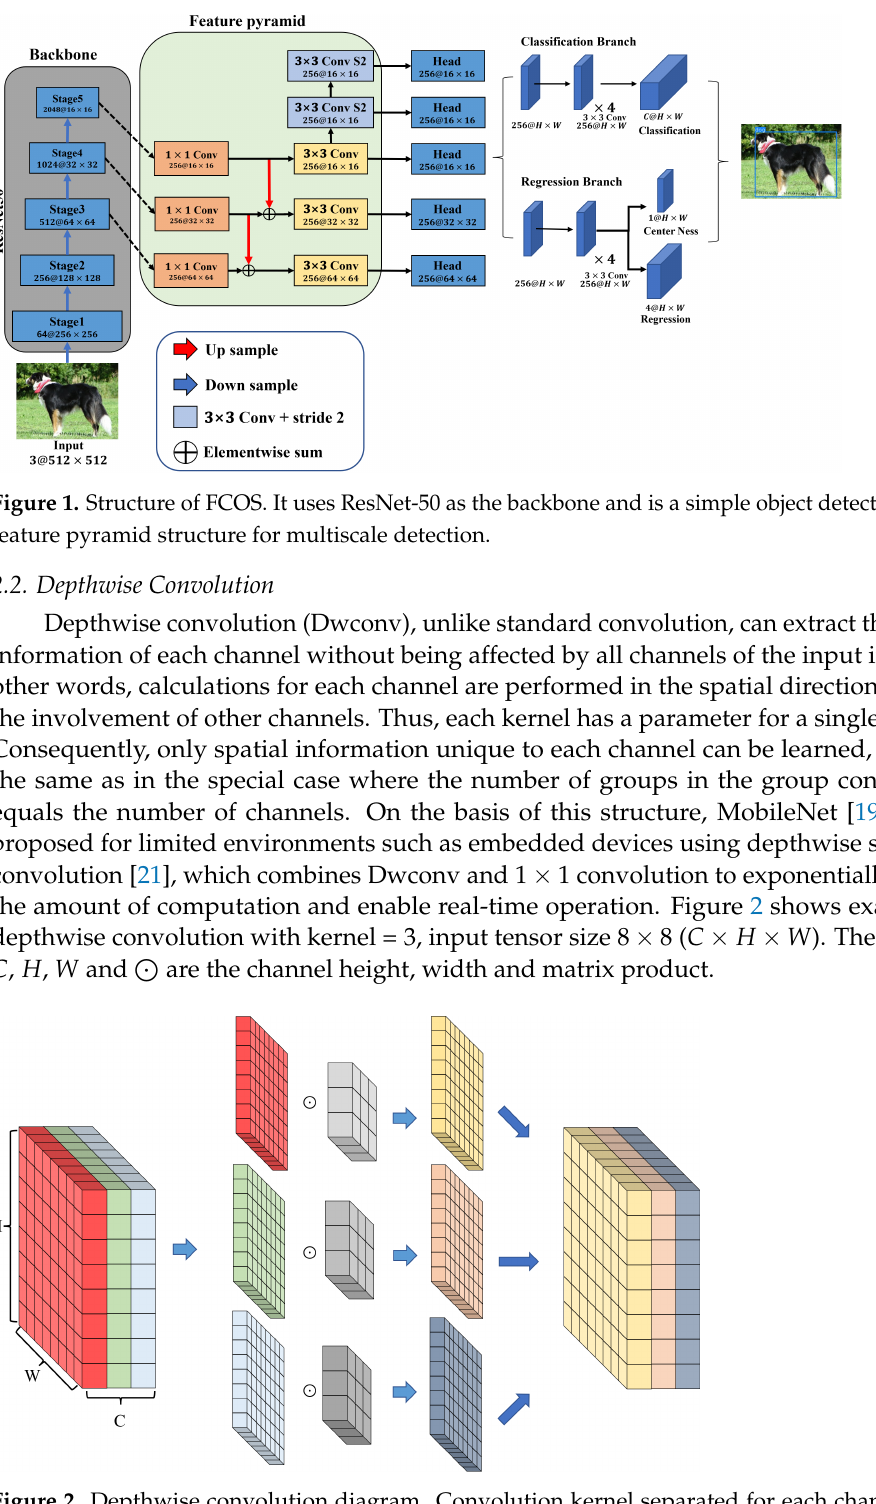
Figure 2. Depthwise convolution diagram. Convolution kernel separated for each channel, a 2D kernel of 3 × 3 is attached to each separated matrix of size 3 × 8 × 8, each convolution operation is performed, and then only channel wise spatial information is learned through